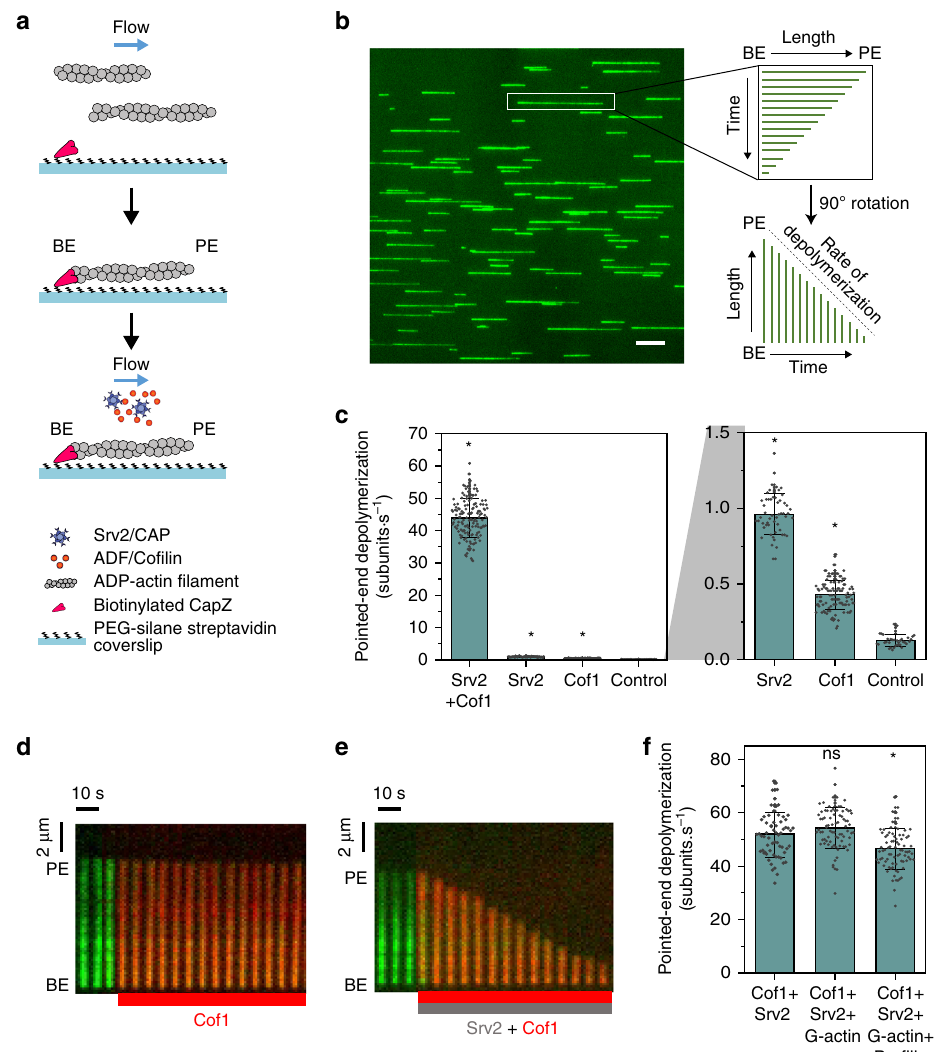
Fig. 1 S. cerevisiae Srv2/CAP and Co fi lin synergize to accelerate actin fi lament depolymerization. a Schematic representation of the experimental strategy. Preformed Alexa-488-labeled actin fi laments were captured by coverslip-anchored biotinylated SNAP-CapZ. After 15 min, 1 µ M Cof1 and/or 0.5 µ M Srv2 (or control buffer) was introduced into the chamber, and depolymerization was monitored. BE barbed end, PE pointed end. b Representative fi eld of view showing anchored fi laments aligned under fl ow, and the methodology used for determining the rate of pointed-end depolymerization from the slope of kymographs. Scale bar, 10 µ m. c Rates (±sd) of pointed-end depolymerization in the presence of 1 μ M Cof1 and/or 0.5 μ M Srv2. Right: Magni fi ed view of Control, Cof1, and Srv2 data. *statistical comparison by two-sample t test against Control ( p < 0.05). Number of fi lament ends analyzed for each condition (left to right): 149, 55, 110 and 37. d Merged two-color kymograph of an Alexa-488-labeled actin fi lament (green), with 1 μ M Cy3-Cof1 (red) introduced at the beginning of the red bar (see Supplementary Movie 1). e Same as ( d ) but with 1 μ M Cy3-Cof1 (red) and 0.5 μ M Srv2 (unlabeled). f Rates (±sd) of pointed-end depolymerization by 1 μ M Cof1 and/or 0.5 μ M Srv2 in the presence of 3 μ M G-actin (with or without 6 μ M Pro fi lin). *statistical comparison by two-sample t test against Cof1 + Srv2 ( p < 0.05). ns no evidence for signi fi cance at p = 0.05. Number of fi lament ends analyzed for each condition (left to right): 64, 83 and 84. Source data are provided as a Source Data fi le. All experiments were performed at least three independent times, and yielded similar results. Data shown are from one